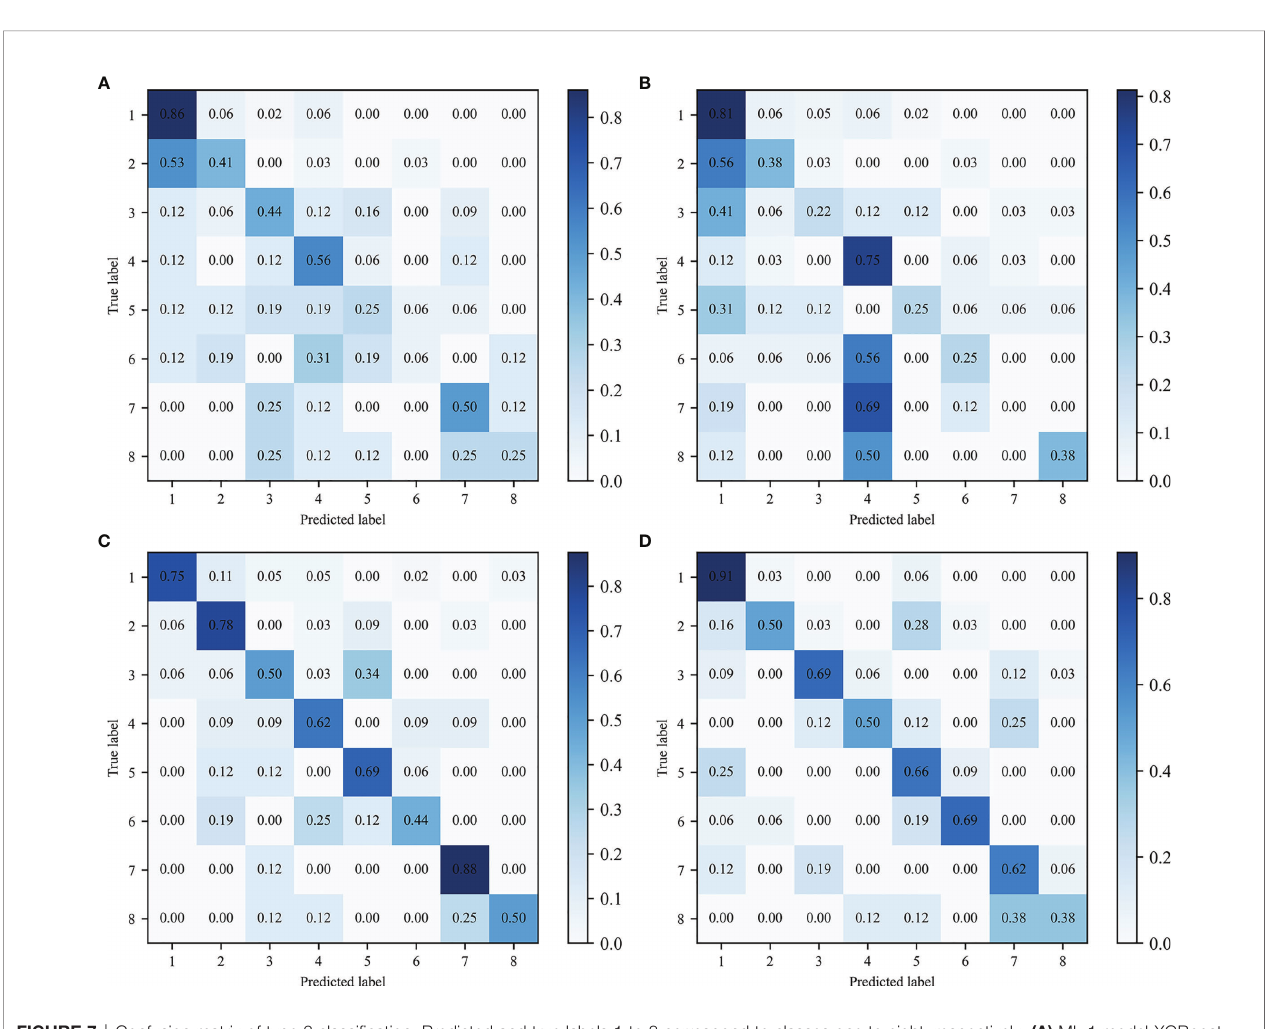
FIGURE 7 | Confusion matrix of type 3 classi fi cation. Predicted and true labels 1 to 8 correspond to classes one to eight, respectively: (A) ML 1 model-XGBoost, (B) ML 2 model- XGBoost, (C) ML 3 model-LDC, (D)